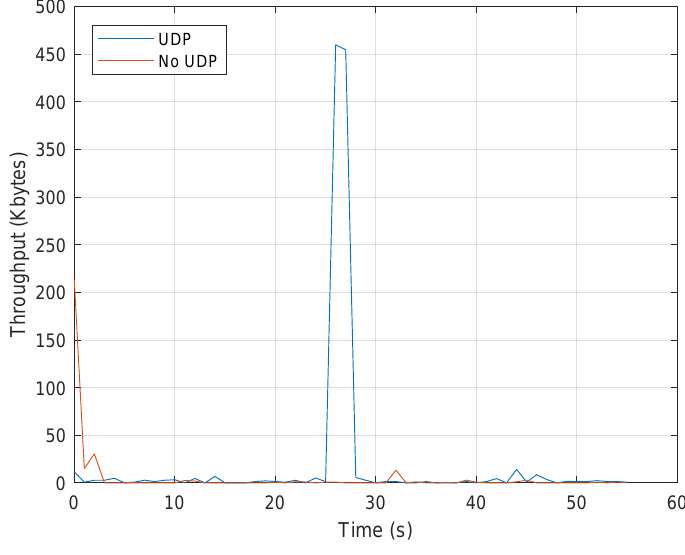
Figure 5. Throughput values during the DoS